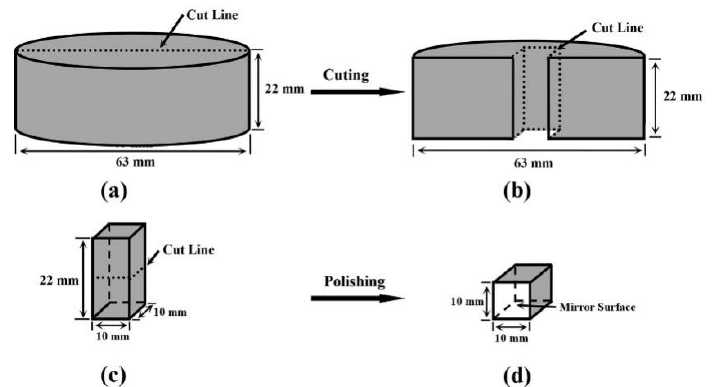
Figure 1. Samples preparation process. ( a – c ) Metallographic sample cutting process; ( d ) Metallographic sample polishing process.